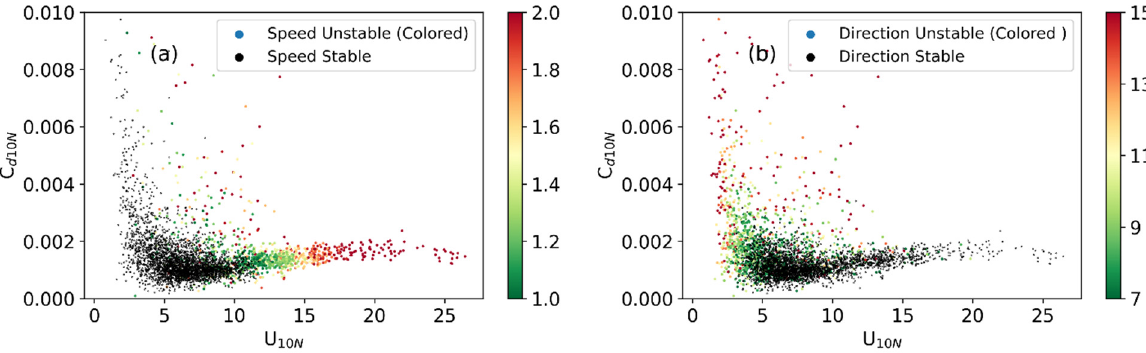
Figure 7. C d 10 N as a function of U 10 N . Left panel ( a ): Runs with std ( u ) ≤ 1 m/s are marked as black, runs with Figure 7. 𝐶 (cid:3031)(cid:2869)(cid:2868)(cid:3015) as a function of 𝑈 (cid:2869)(cid:2868)(cid:3015) . Left panel ( a ): runs with 𝑠𝑡𝑑(𝑢) (cid:3409) 1 m/s are marked as black, runs with 𝑠𝑡𝑑(𝑢) (cid:3408) 1 m/s are colored by 𝑠𝑡𝑑(𝑢) . Right panel ( b ): runs with 𝑠𝑡𝑑(𝜃) (cid:3409) 7 ° ) are marked as black, runs with 𝑠𝑡𝑑(𝜃) (cid:3408) 7 ° are col- std ( u ) > 1 m/s are colored by std ( u ) . Right panel ( b ): Runs with std ( θ ) ≤ 7 ◦ ) are marked as black, runs with std ( θ ) > 7 ◦ ored by 𝑠𝑡𝑑(𝜃) . are colored by std ( θ )